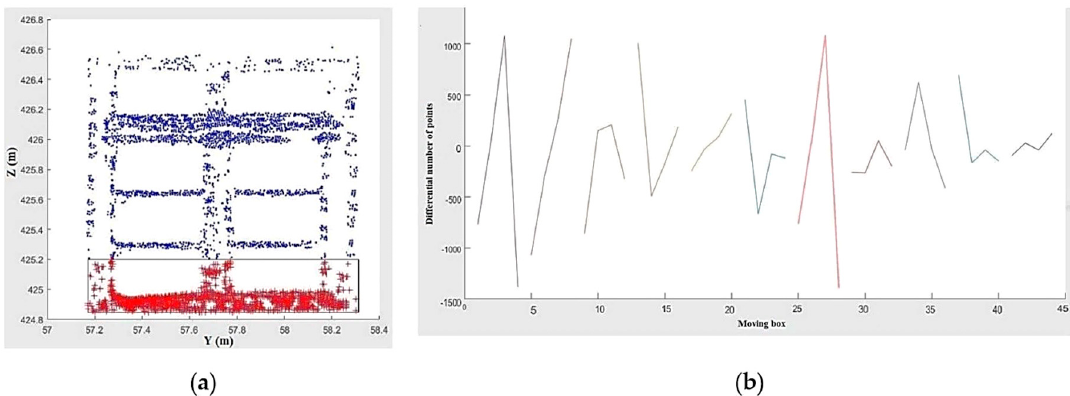
Figure 11. Utilizing the Gestalt principles in window detection. ( a ) Partitioning a window via moving a box. ( b ) Differential number of points for the consecutive sub-segments, which belong to different window and non-window patches (10 steps).